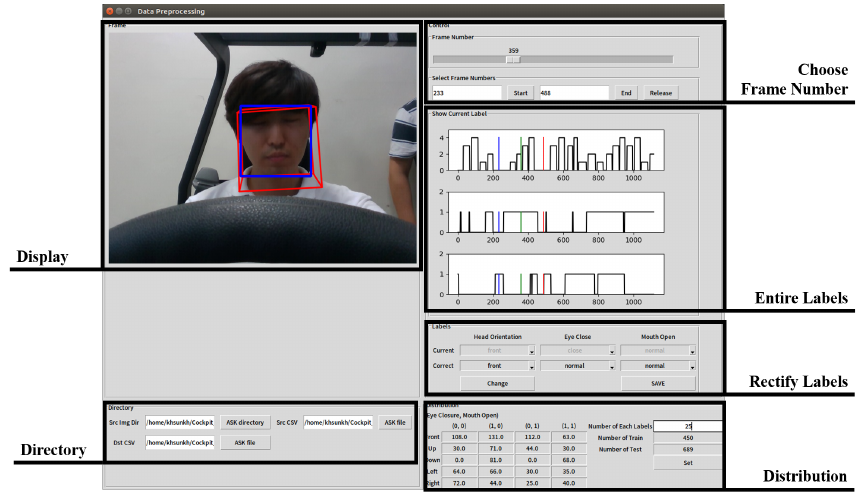
Figure 8. Correcting labels